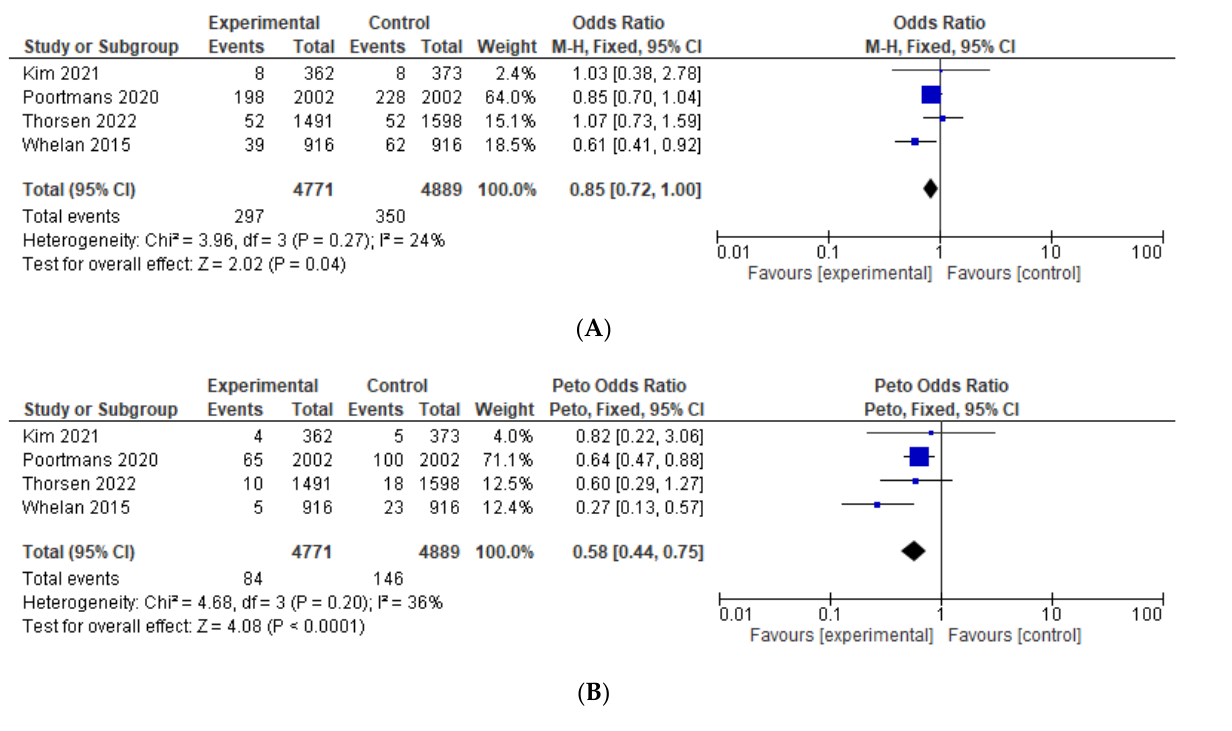
Figure 3. Forest plots for the efficacy, odds ratio for: ( A ) loco-regional recurrence; ( B ) regional recurrence. The weight of each trial in the meta-analysis is represented by the size of the squares. The estimated pooled effect is represented by a diamond shape. p values are two-sided. References: Hen-